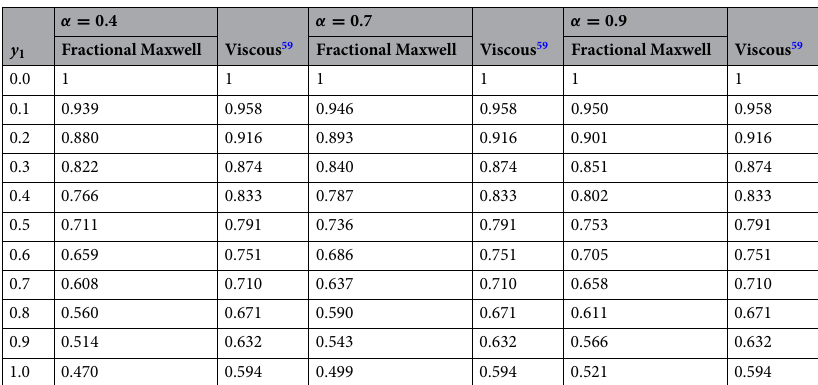
Figure 2 depicted to see the variation of fractional parameter α . The maximum decay in velocity can be obtained for small time. It is clear from the Fig. 2 by increasing values of α velocity exhibits the maximum decay for small time. This behavior can be reversed for large values of time is shown in Fig. 3. Further, fractional parameter can be used to control the momentum boundary layer thickness. The relationship of velocity of clay nanoparticles and volume fraction φ is discussed in Fig. 4. For large values of φ fluid velocity will decrease as